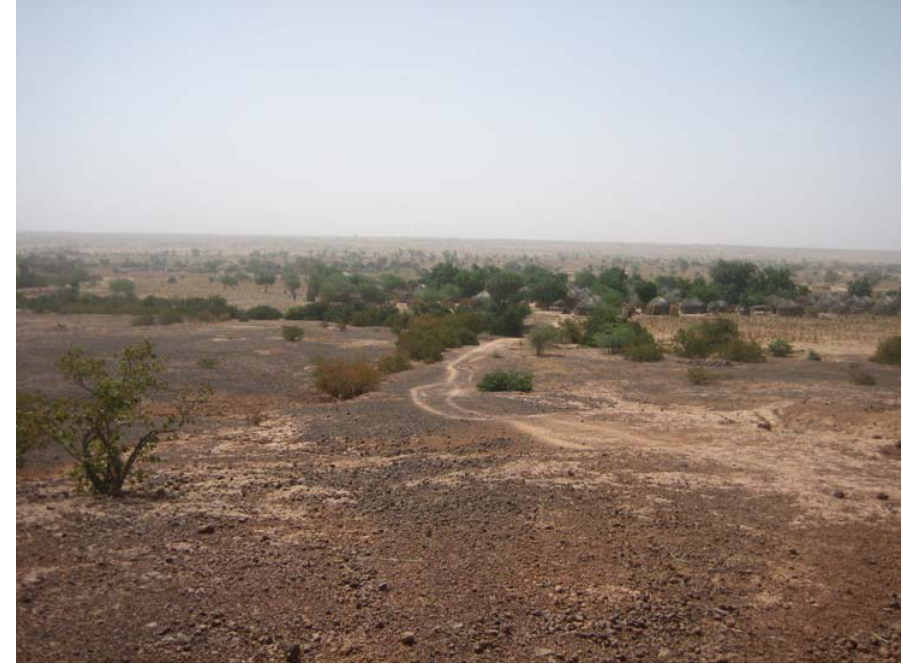
Figure 14. Kirib Kaina seen from the Plateau. The slopes connecting the plateau and the valley are especially dark. Photo: Frédéric Alexandre (November 2009).